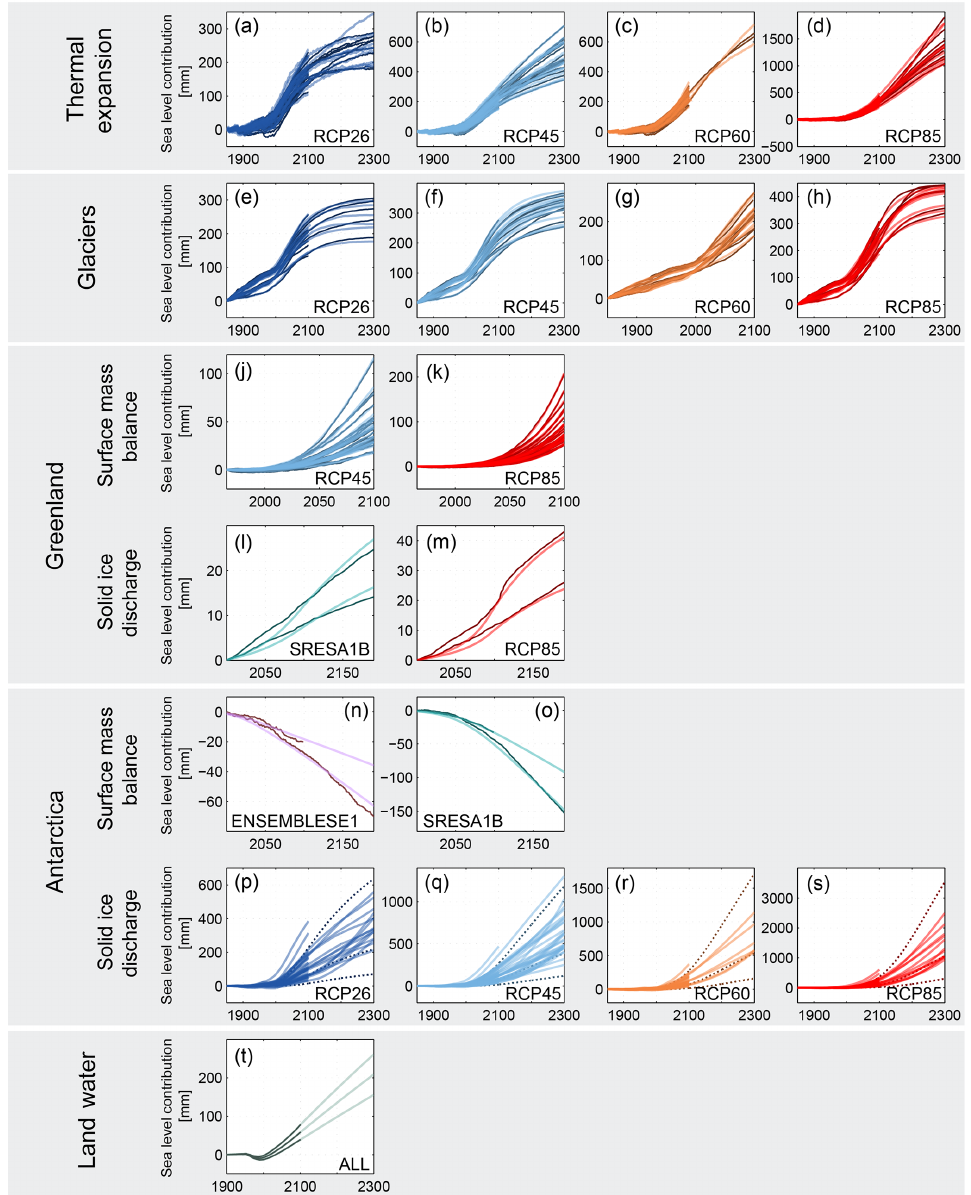
Figure 3. MAGICC sea level model calibration results for thermal expansion (a–d) , global glaciers (e–h) , Greenland surface mass balance (j– k) and solid ice discharge (l–m) , Antarctic surface mass balance (n–o) , and solid ice discharge (p–s) , as well as land water (t) . The panels show scenario-specific calibrated MAGICC sea level responses as colored lines, with underlying reference data as thin dark lines. Antarctic solid ice discharge reference 90% range plus corresponding median are provided as thin dashed lines. Climate-independent land water projections are identical to the reference data until 2100 (see Sect. 2.5). Please note that x and y axis ranges differ for individual